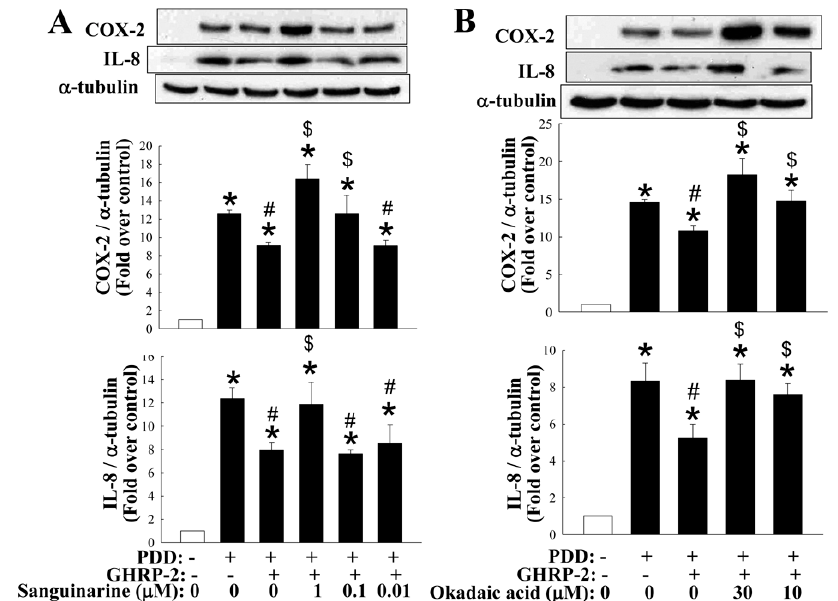
Figure 10. Involvement of MKP-1 and PP2A in the inhibitory effect of GHRP-2 on PKC-mediated COX-2 and IL-8 expression. To test the involvement of MKP-1 or PP2A in GHRP-2 inhibition of PKC-induced COX-2 and IL-8 expression, plated KGN cells were pretreated with GHRP-2 (1 µ M) or a combination of GHRP-2 with either the MKP-1 inhibitor sanguinarine (0.01, 0.1, and 1 µ M) ( A ) or the PP2A inhibitor okadaic acid (10, and 30 µ M) ( B ) for 2 h, and then PDD (100 nM) was included for an additional 12 h. The intracellular COX-2 and IL-8 protein expression levels were monitored by Western blotting assay. The results represent the means ± SEM ( n = 4) separate experiments. * p < 0.05 compared with the control; # p < 0.05 compared with the PDD treatment; $ p < 0.05 compared with the combined GHRP-2 and PDD treatment.